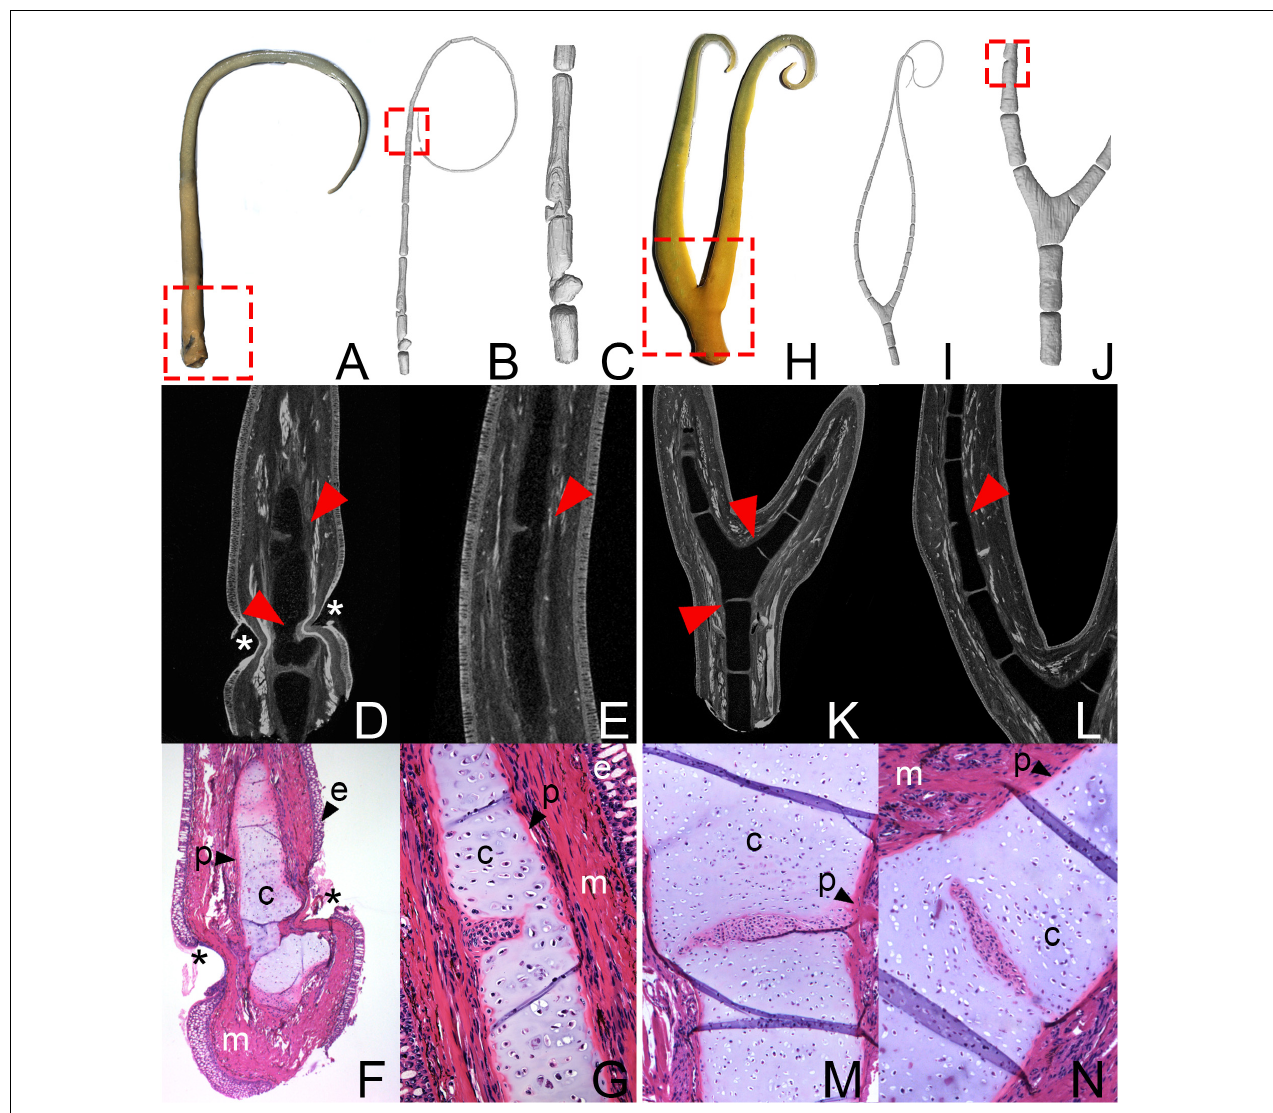
FIGURE 1 | (A–G) Pectoral fin of Lepidosiren paradoxa (ZMB_Pisces_37121). (A) Exterior view with the suspected bite site (dashed box). 3D reconstruction: (B) of the entire fin, dashed box shows area of fused elements, and (C) detailed view of the proximal fin area. µ CT scans: (D) of the constricted fin area and (E) fusion of the skeletal elements. Arrows indicate fused and constricted skeletal elements. Asterisks indicate area with missing epidermis. Histological serial section with Azan staining (F) of the constricted fin area and (G) fusion of the skeletal elements. (H–N) Bifurcated pectoral fin of Lepidosiren paradoxa (ZMB_Pisces_37121). (H) Exterior view with the suspected bite site (dashed box). 3D reconstruction: (B) of the entire fin and (C) detailed view of the proximal fin area, dashed box shows area of fused elements. µ CT scans: (D) of the bifurcated element and (E) fusion of the skeletal elements. Arrows indicate fused skeletal elements. Histological serial section with Azan staining: (F) of the most proximal part of the bifurcated element and (G) fusion of the bifurcated element with the adjacent skeletal element. c, cartilage; e, epidermis; m, muscles; p,